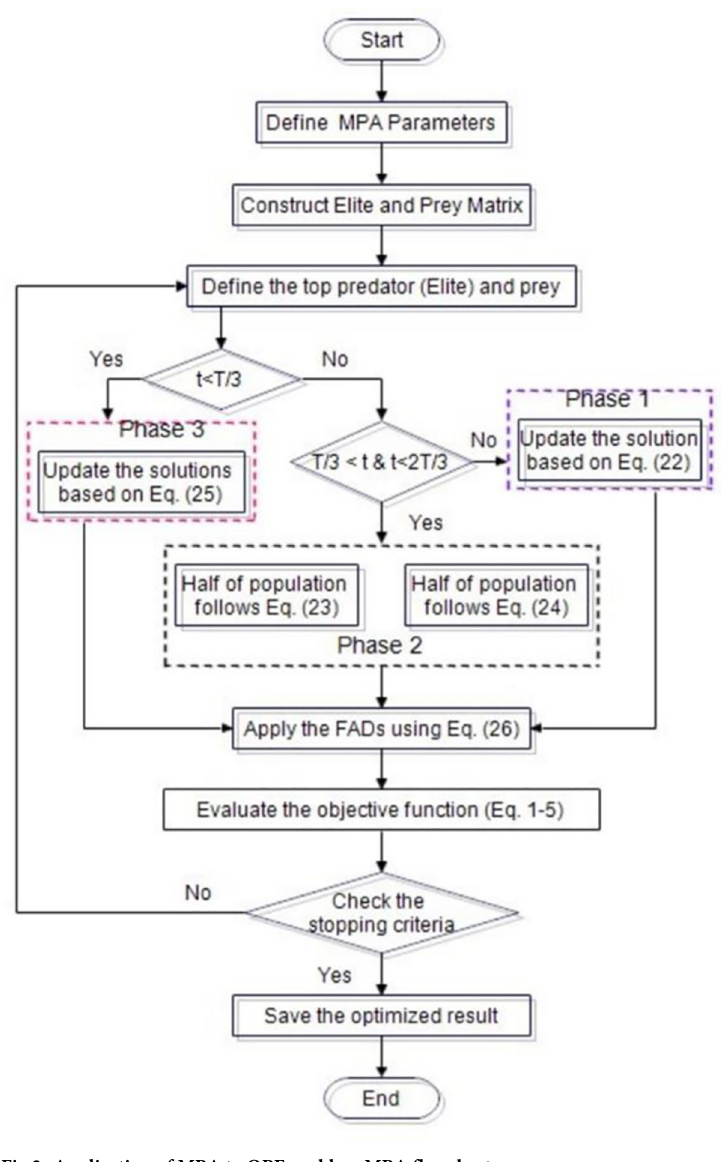
Fig 2. Application of MPA to OPF problem MPA